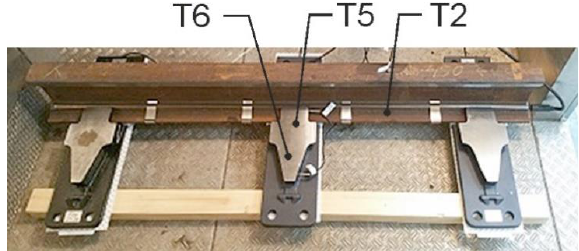
Figure 16. Tested fragment of the turnout stock-rail placed in a climatic chamber subject to resistance heating (RH) and induction heating (IH) [23].